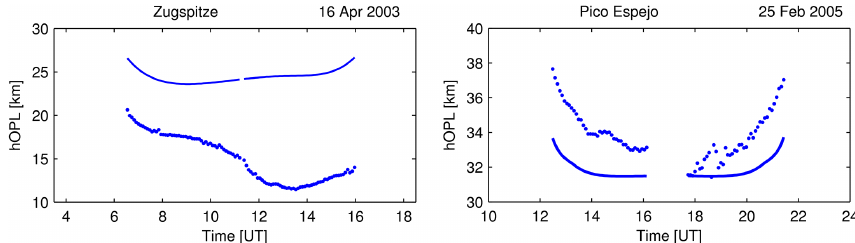
Figure 6. Horizontal optical path length (hOPL) for two single days at Zugspitze (left) and Pico Espejo (right). Here, hOPL is obtained from measured (dotted line) and synthetic (solid line) O 4 DSCDs in the 346–372nm fitting window and only shown for SZA<70 ◦ (see Sect.